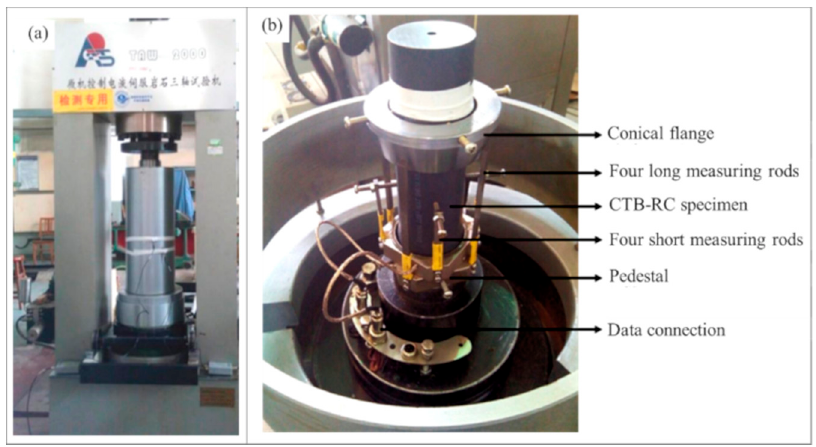
Figure 8. The TCS tester ( a ) and the extensometer ( b ).